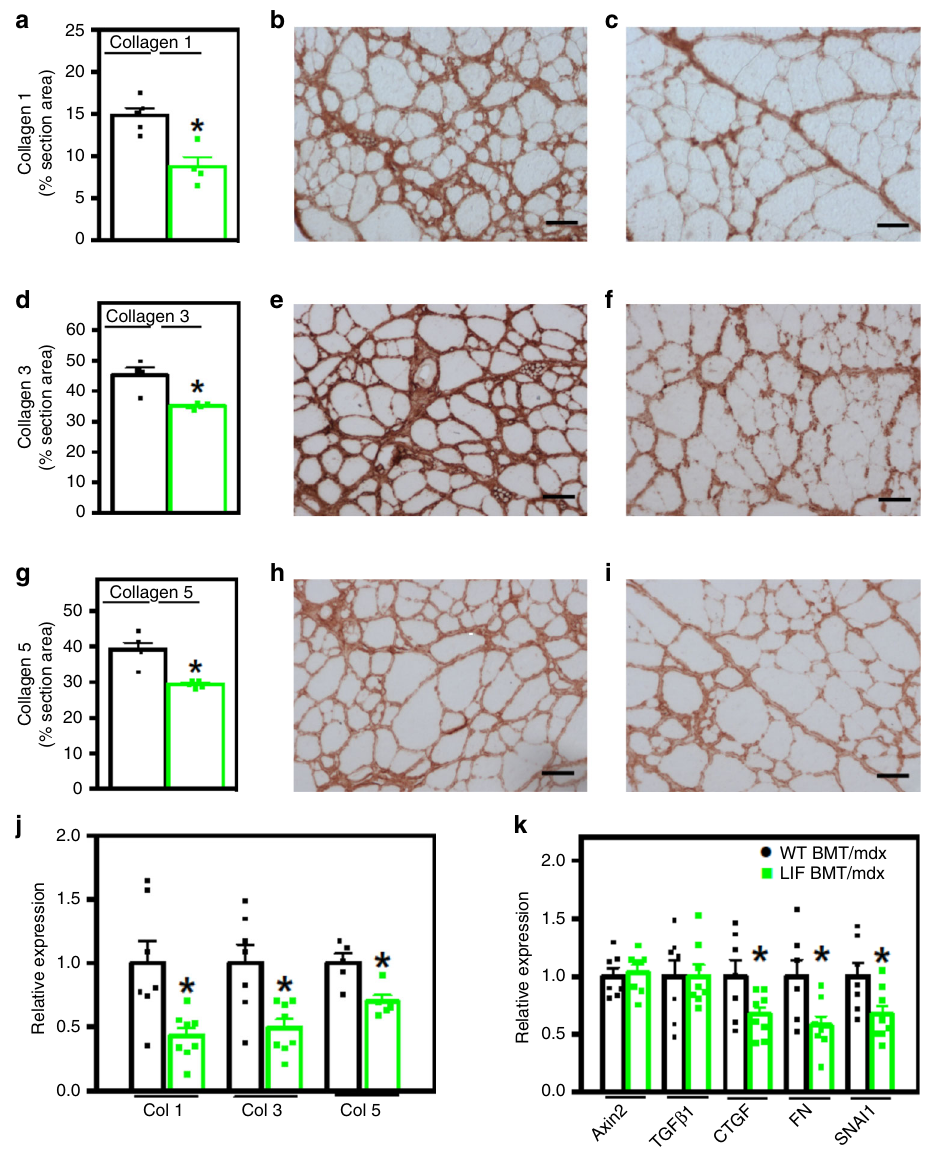
Fig. 5 Transplantation of CD11b/LIF transgenic BMCs into mdx mice reduces muscle fi brosis. a – i TA muscles from WT BMT/ mdx ( b , e , h ) and LIF BMT/ mdx transplant recipients ( c , f , i ) were immunolabeled for collagen types 1 ( a – c ), 3 ( d – f ), and 5 ( g – i ). Bars = 50 µ m. The volume fraction of muscle occupied by collagen types 1 ( a ), 3 ( d ), and 5 ( g ) was reduced in LIF BMT/ mdx recipients. N = 5 for WT BMT/ mdx and LIF BMT/ mdx data sets, except n = 4 WT BMT/ mdx collagen type 3 and LIF BMT/ mdx collagen type 1. * Indicates signi fi cantly different from WT BMT/ mdx recipients at P < 0.05. F -test collagen type 3 ( P = 0.0055) and type 5 ( P = 0.0155). For all histograms in the fi gure, the bars indicate mean ± sem. j QPCR data presented as mean ± sem shows that LIF BMT/ mdx recipients also had reduced expression of transcripts encoding Col1a1 , Col3a1 , and Col5a3 . N = 7 or 8 for WT BMT/ mdx and LIF BMT/ mdx data sets, respectively, except n = 5 for Col5a3 data sets. k QPCR analysis of transcripts associated with the pro- fi brotic Wnt- ( Axin2 ) and TGF β 1-signaling ( Tgfb1 , Ctgf , Fn1 , and Snai1 ) pathways showed reduced expression of Ctgf , Fn1 , and Snai1 in LIF BMT/ mdx recipients. N = 7 or 8 for WT BMT/ mdx and LIF BMT/ mdx data sets, respectively, except n = 7 for LIF BMT/ mdx Axin2 group. * Indicates signi fi cantly different from WT BMT/ mdx recipients at P < 0.05. P- values based on two-tailed t- test. F -test Col1a1 ( P = 0.0250). Source data are provided as a Source Data fi indicates that satellite cells had a less fi brogenic phenotype in shifted away from a myogenic phenotype, toward a fi brogenic CD11b/LIF recipients. Expression of Serpinh1 , the gene that phenotype 40,41 . Our data show that the transgene reduced the proportion of satellite cells that expressed ERTR7 in mdx muscle encodes HSP47, was also reduced 24% in the whole muscle lysate in vivo, similar to the reduction of satellite cells expressing HSP47 of CD11b/LIF recipients (mean ± sem: WT BMT/ mdx 1 ± 0.08 (Fig. 7c, d). and LIF BMT/ mdx 0.76 ± 0.06, n = 7 and 8 per data set, respec- We also tested whether the CD11b/LIF transgene affected the tively, P = 0.03; two-tailed t -test ) . We also assayed whether phenotype of myogenic progenitor cells (MPCs) in later stages of transplantation of CD11b/LIF BMCs affected the proportion of mdx pathology by assaying for changes in the expression of satellite cells that expressed ERTR7 in vivo. ERTR7 was chosen in fi brogenic genes in MPCs that were freshly-isolated from muscles addition to HSP47 because satellite cells in injured and aging of 14-months-old mice. MPCs (CD11b-CD31-CD45-Sca1- α 7 muscle that display elevated levels of ERTR7 expression have